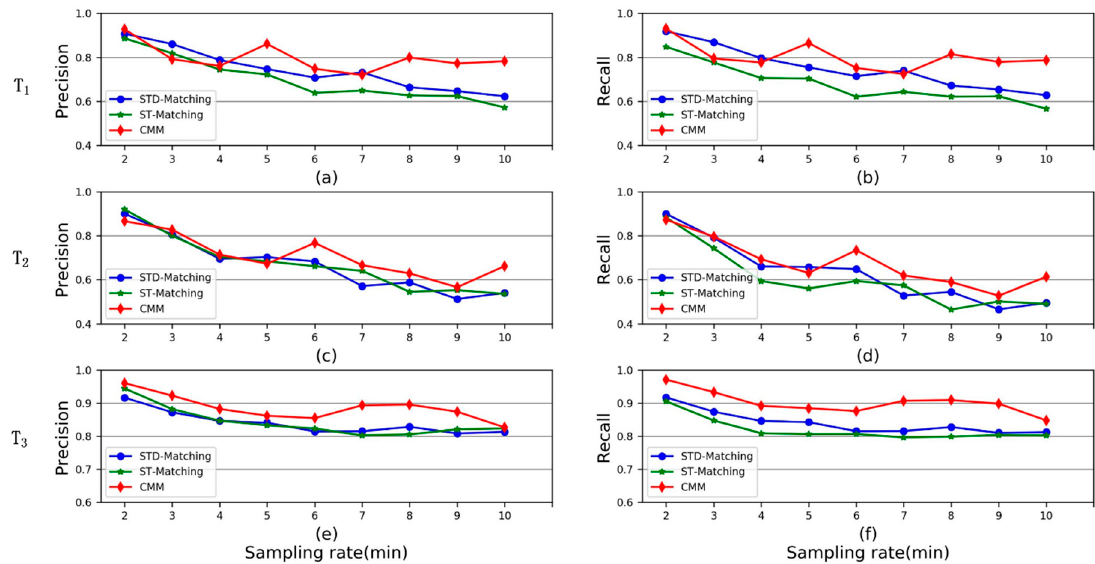
Figure 14. The performance comparison of CMM, ST-Matching and STD-Matching under different scenarios. ( a , b ) Scenario T 1 . ( c , d ) Scenario T 2 . ( e , f ) Scenario T 3 .